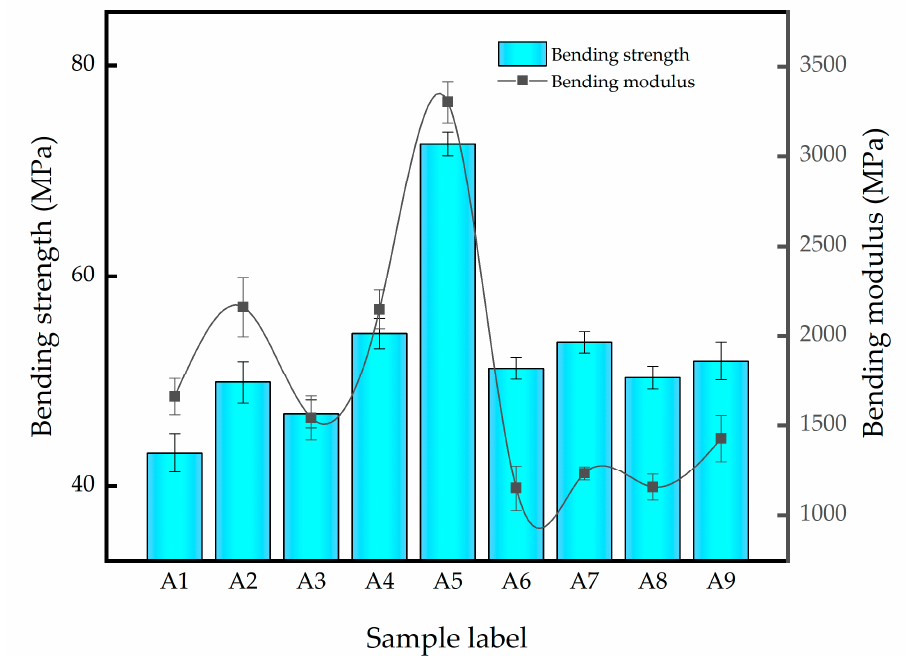
Figure 2. Flexural strength and modulus of different PLA/PBS composites.